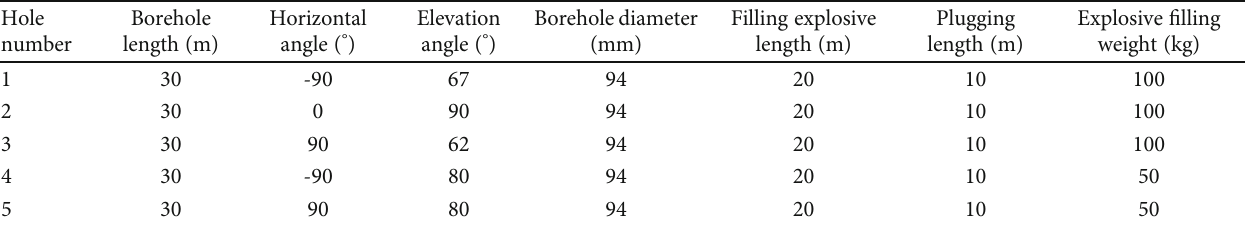
Figure 17: End precracking blasthole layout scheme. (a) Plane diagram. (b) Section diagram in the headgate. (c) Section diagram in the Table 5: Parameters of end precracking blasthole drilling and fi lling explosive.